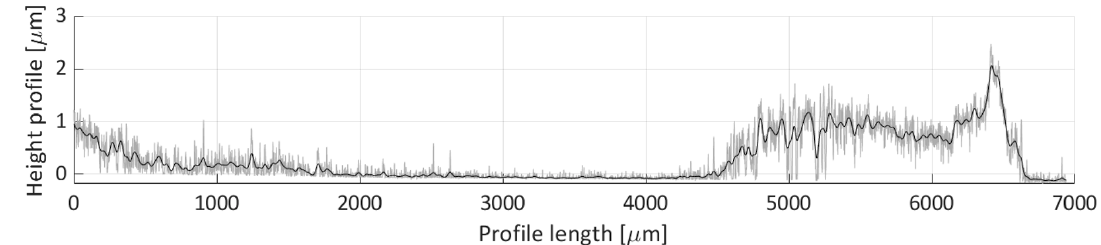
Figure 20. Height profile for the V2 line. Horizontal height profile 1 (H1) is shown in Figure 21. The majority of the profile’s height is below 0.5 μ m, with only one discernible particle distribution, spanning 200 to 1000 μ m along the profile length. This profile shows the distribution of sparsely deposited particles, without clear deposit formation. Figure 21. Height profile for the H1 line. Figure 22 shows the H2 profile scan. In this figure, a single particle distribution can be detected, starting around 250 μ m and ending at 800 μ m on the profile length axis. The particles deposited along this line form a deposit with a ~300 μ m width and an average height of around 0.5 μ m.